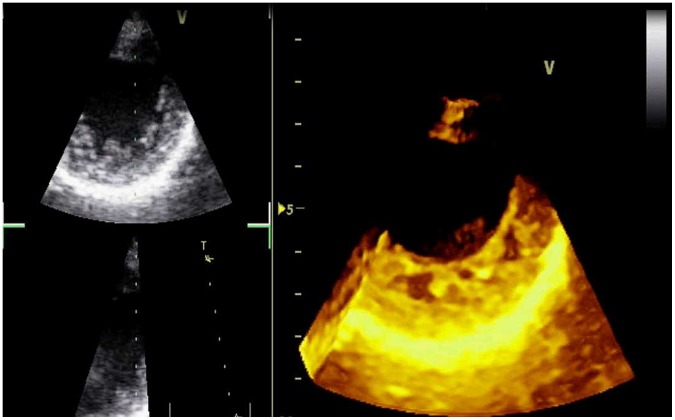
Real-time three-dimensional echocardiographic appearance from parasternal short-axis view of a patient with isolated left ventricular noncompaction.